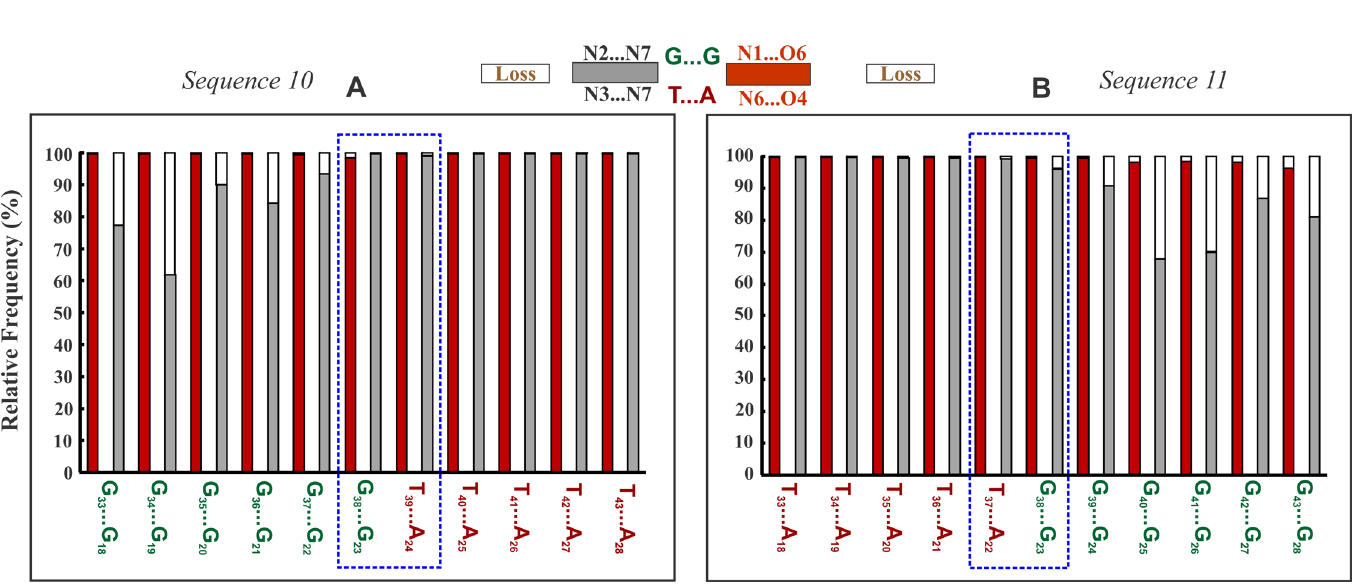
Fig 6. Demonstration of the retention of Canonical Hoogsteen hydrogen bonds at the G * GC/T * AT triplex junction interface. Frequency of incidence (red & gray colour part) and loss (void part) of Hoogsteen hydrogen bonds in the NIBTs at the GT step — Sequence 10 (A) and at the TG step — Sequence 11 (B) triplex junction interfaces. Hydrogen bonds retention is highlighted by the enclosed blue